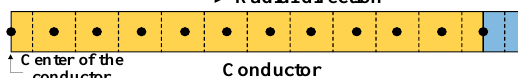
i and j being, respectively, the indices related to the spatial and temporal steps, so that T ij = T ( i Δ x , j Δ t ) corresponds to the average temperature of the i -th node calculated at the j -th time step. Finally, a ij , b ij , c ij and d ij are constant coefficients. Equation (4) calculates the